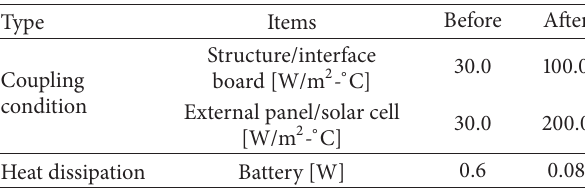
Table 8: Summary of specific parameters variation for TMM